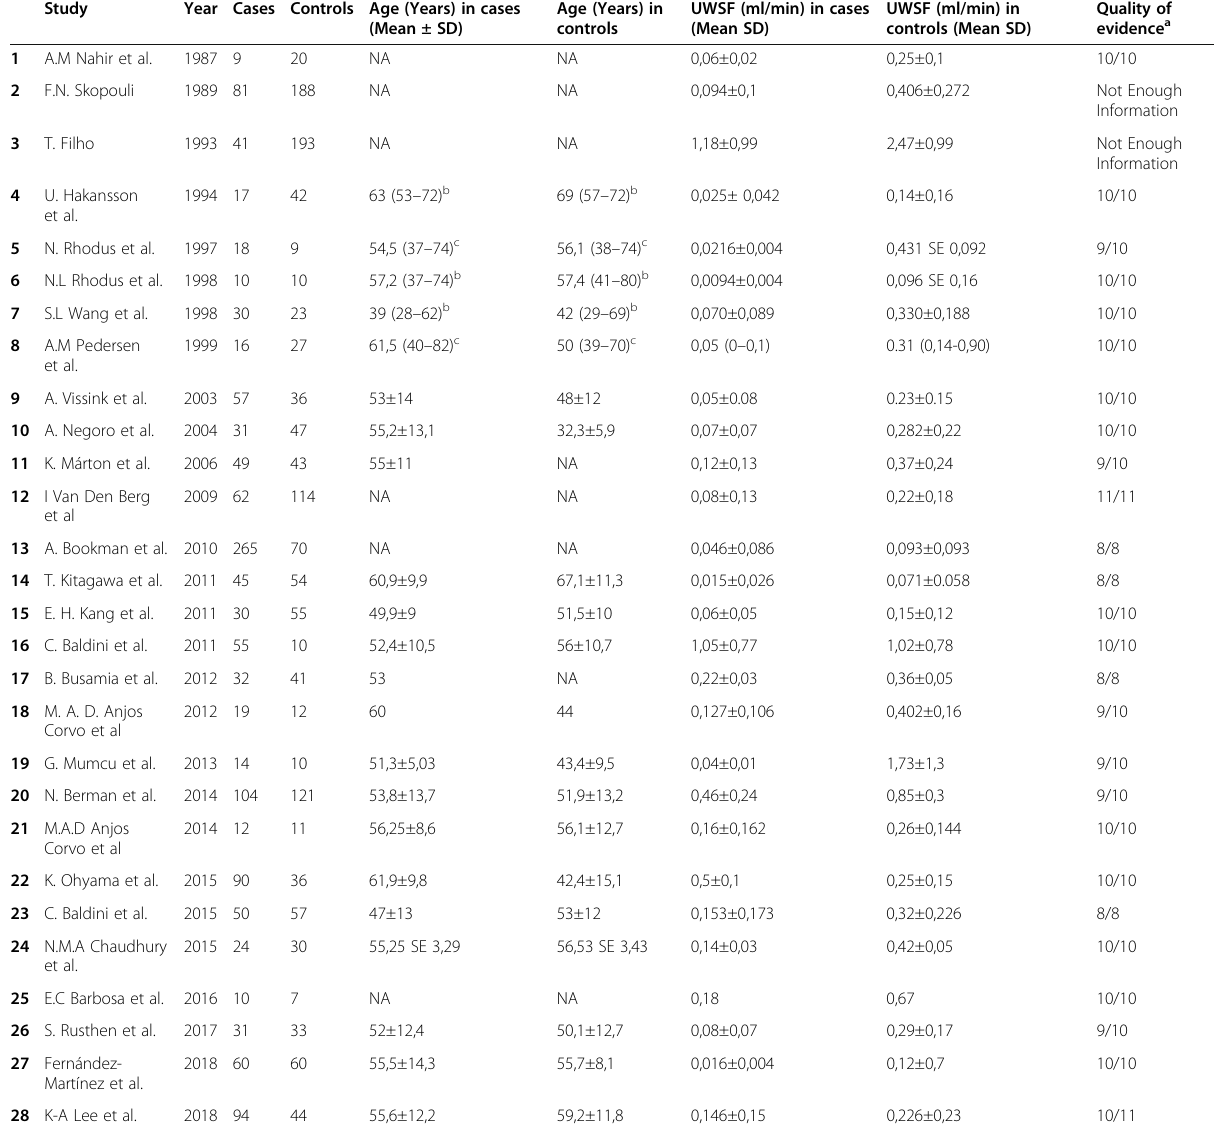
Table 3 Main results of the studies included in the meta-analysis